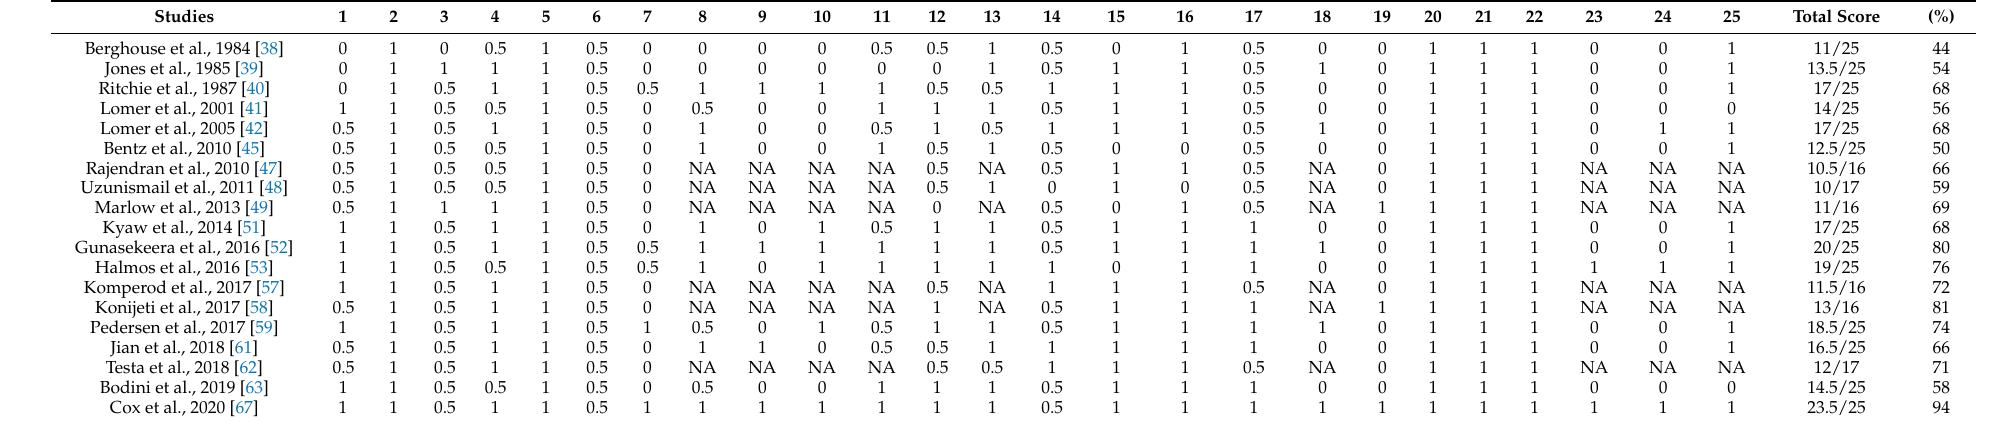
Table 3. Methodological quality analysis according to the CONSORT (Consolidated Standards of Reporting Trials) guide for reporting clinical trials.